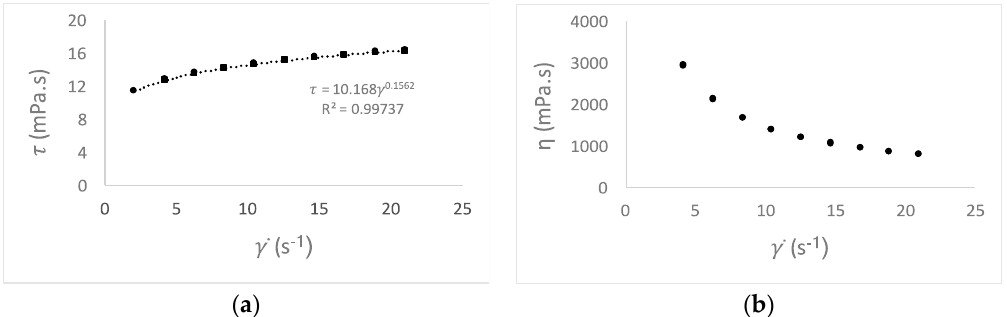
Figure 1. Flow behavior curve and power law model ( ..... ) fitting ( a ) and relation between apparent viscosity and the shear rate ( b ), at 25 ± 1 °C with an up-down rate ramp.